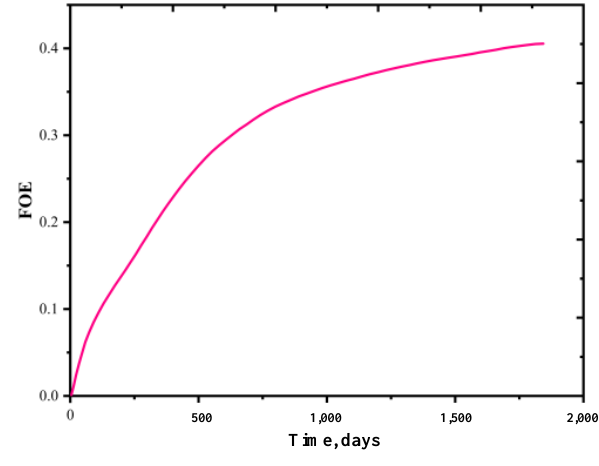
Figure 9. Field oil efficiency for horizontal wells.